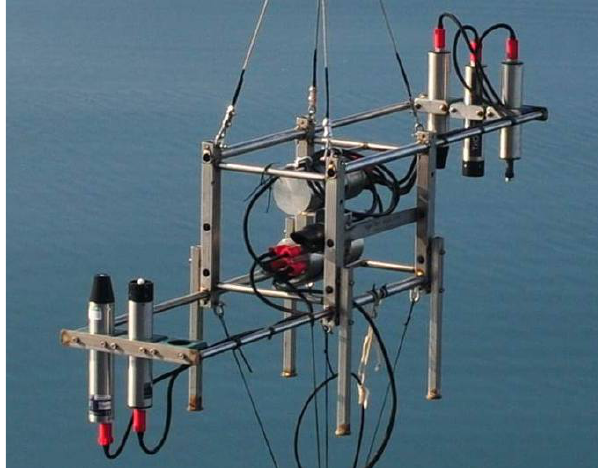
Figure 3. The instrument package used to measure the irradiance quartet and upwelling radiance. As shown, the five radiometric sensors are aligned to the same depth level.